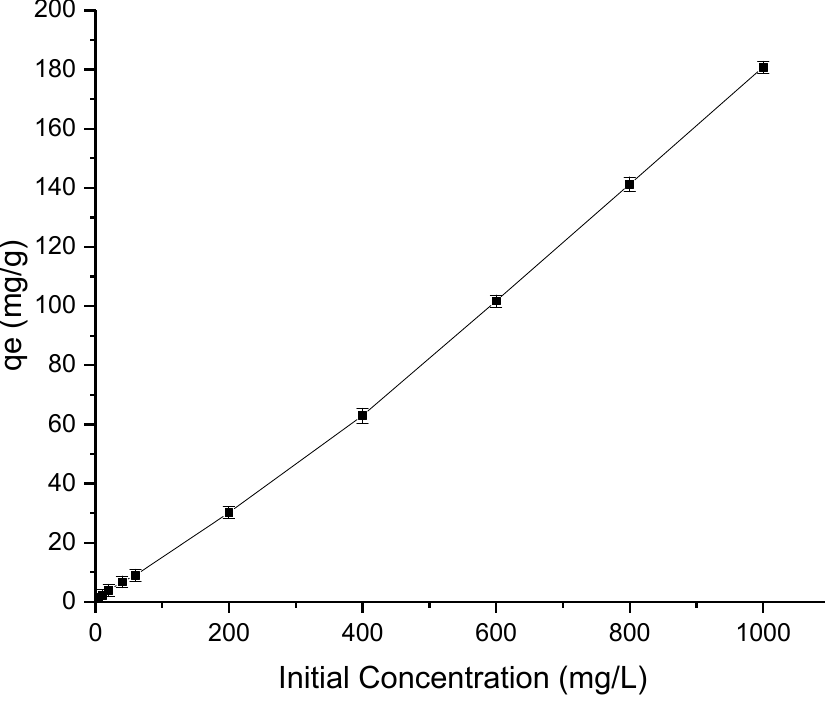
Figure 4. Effect of initial concentration on the lead adsorption capacity of the HAP particles.